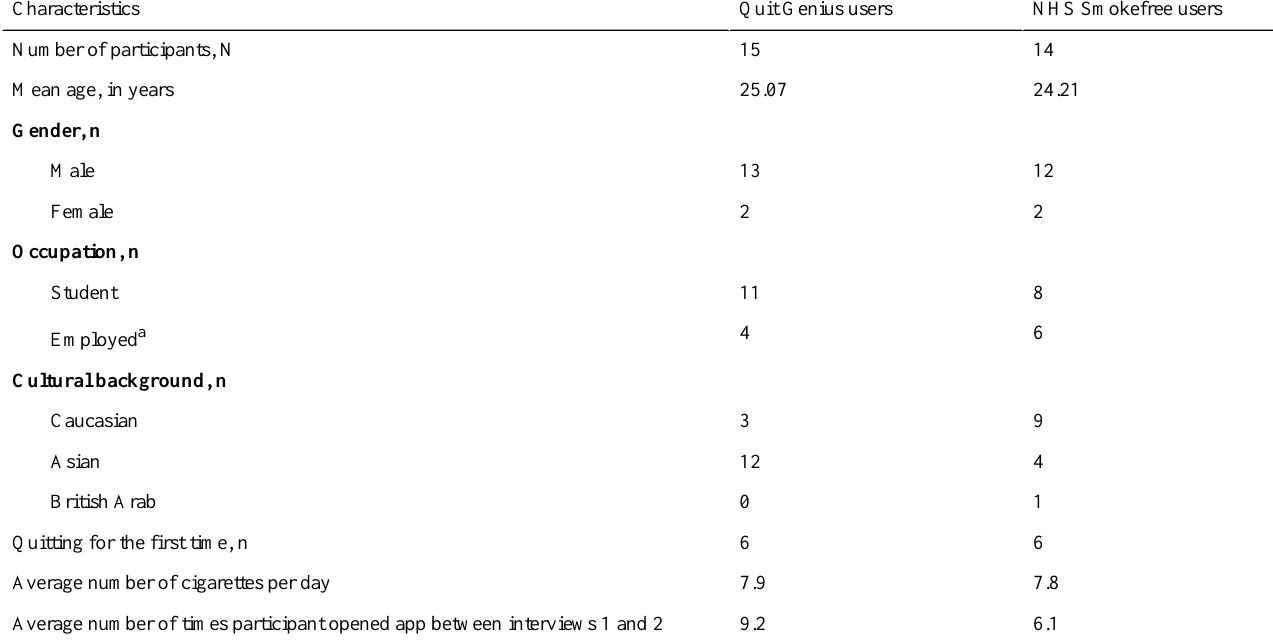
Table 1. Demographic data of the final sample of participants. NHS: National Health